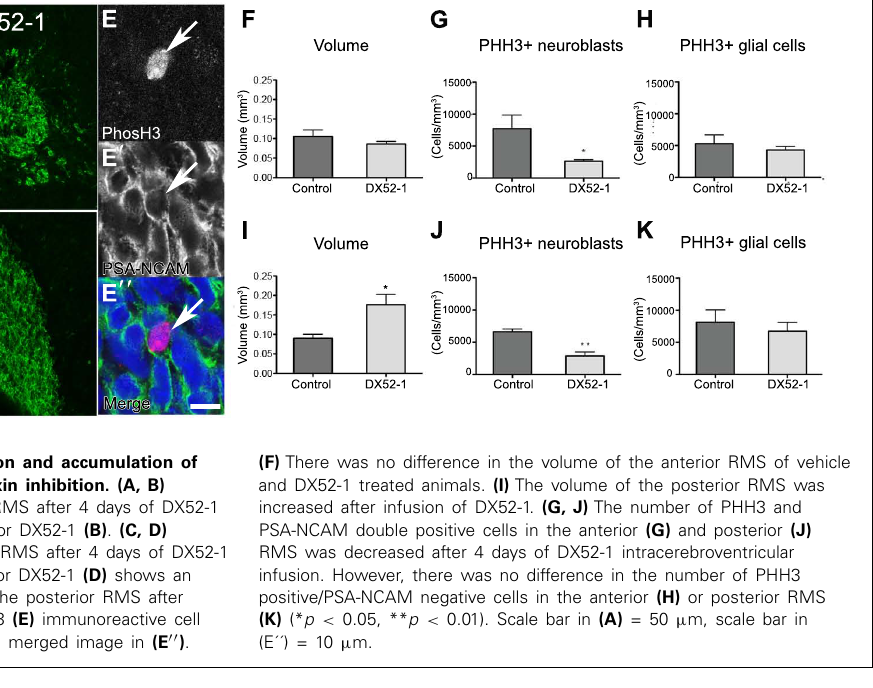
FIGURE 6 | Decreased neuroblast proliferation and accumulation of neuroblastsin the posterior RMS after radixin inhibition. (A, B) PSA-NCAM immunoreactivity in the anterior RMS after 4 days of DX52-1 intracerebroventricular infusion of vehicle (A) or DX52-1 (B) . (C, D) PSA-NCAM immunoreactivity in the posterior RMS after 4 days of DX52-1 intracerebroventricular infusion of vehicle (C) or DX52-1 (D) shows an accumulation of PSA-NCAM + neuroblasts in the posterior RMS after radixin inhibition. (E, E (cid:3) , E (cid:3)(cid:3) ) Example of PHH3 (E) immunoreactive cell expressing PSA-NCAM (E (cid:3) ) and corresponding merged image in (E (cid:3)(cid:3) ) .